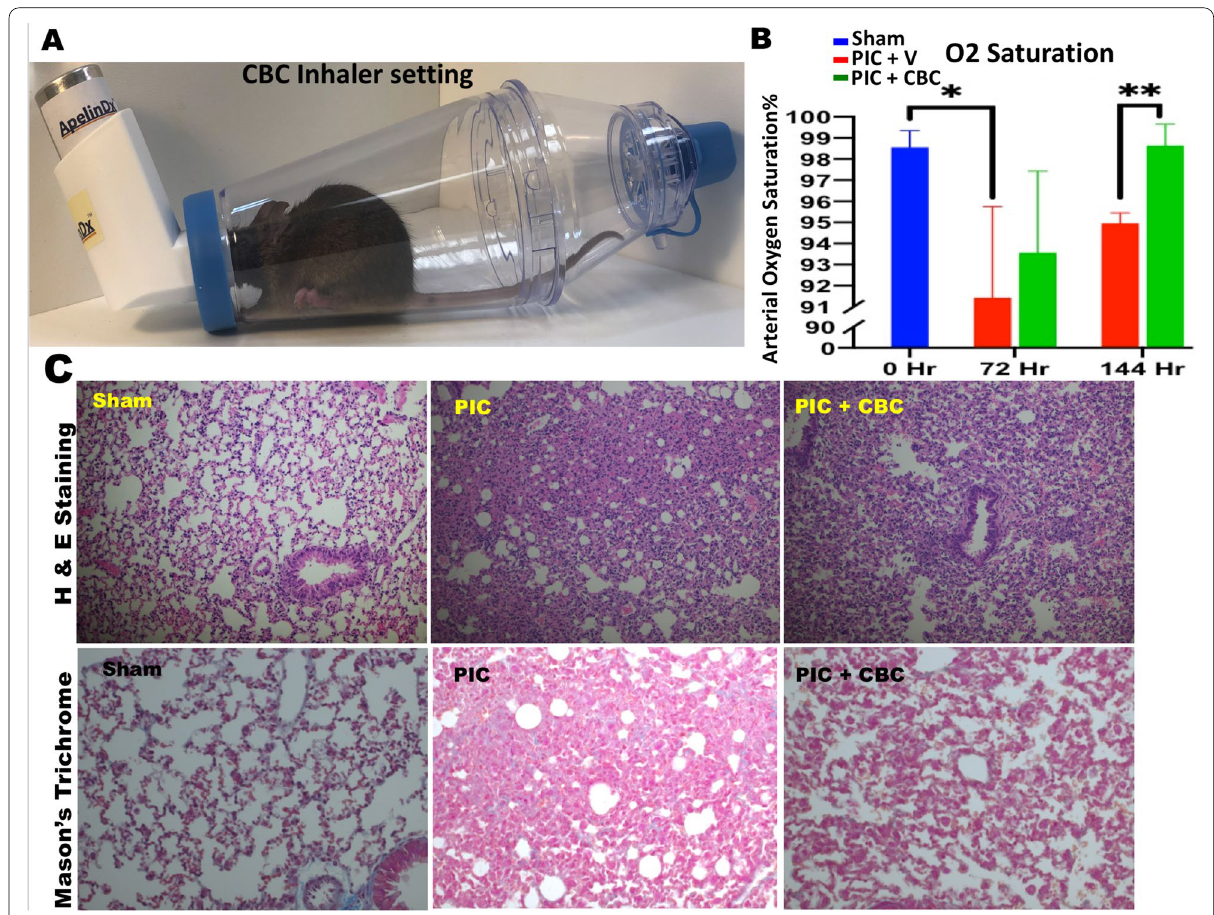
Fig. 1 Inhalant cannabichromene (CBC) improved pulmonary function. A Treating mouse model of acute respiratory distress syndrome (ARDS) with inhalant CBC, specifically designed cone-shaped spout of the inhaling device (ApelinDx tm ) connected to spacer completely sealed for a soft, comfortable, and insuring delivery of inhalant CBC to the mice. B Blood oxygen saturation was increased by ~8% towards a normal level (Blue bar) in mice treated with Poly (I:C) (PIC) followed by the treatment of inhalant CBC (PIC CBC) (Green bar) compared to the untreated group (PIC) (Red + bar) (** p <0.05, bars show means / standard deviation, SD). C Histological analysis, hematoxylin and eosin (H&E upper panels), and Masson’s + − trichrome (MT lower panels) demonstrated that Poly (I:C) caused the destruction of morphology and architecture of lung in mice with ARDS compared to the normal control group (sham). Inhalant CBC was able to improve the lung structure towards a normal status (PIC +